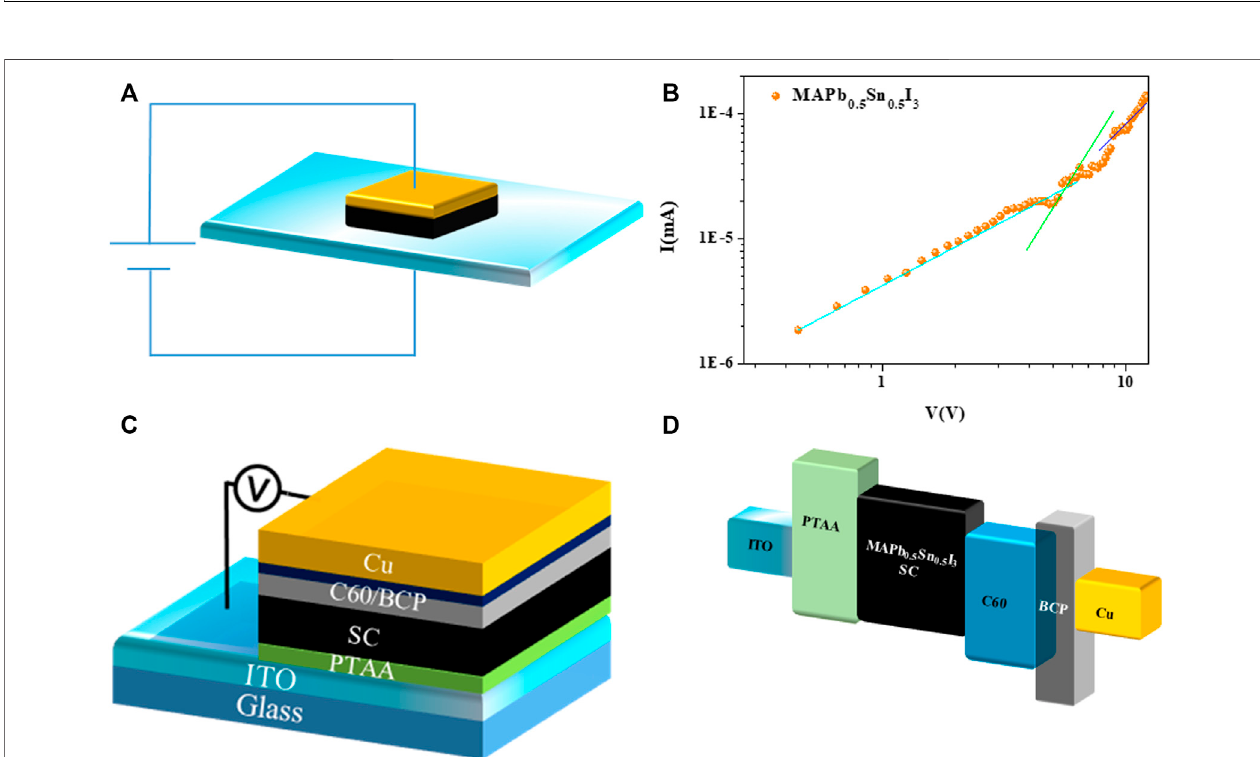
FIGURE5|(A) Schematicdevicestructure. (B) Darkcurrent – voltagecurves ofhole-onlydevicesbasedonaMAPb 0.5 Sn 0.5 I 3 single-crystalthin fi lm. (C) Schematic device structure and (D) energy band diagram of MAPb 0.5 Sn 0.5 I 3